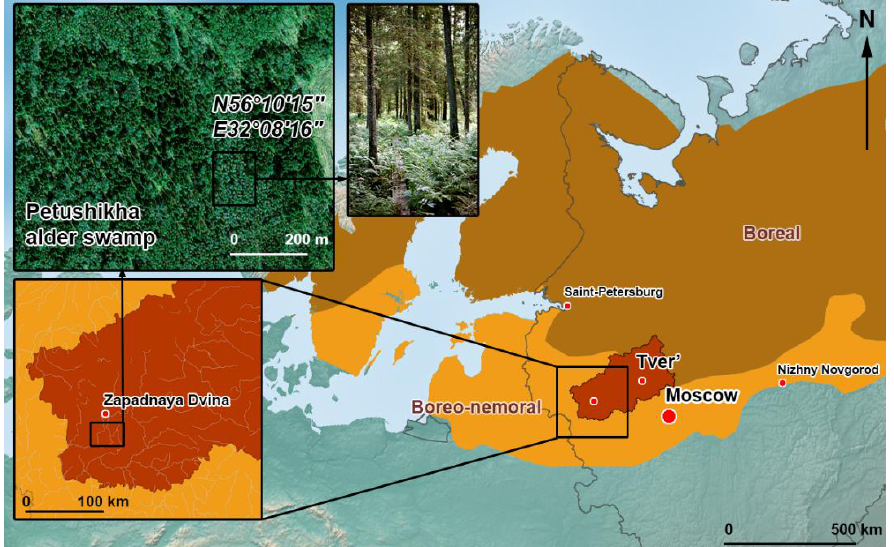
Figure 1. Location of the Petushikha alder swamp in European Russia.